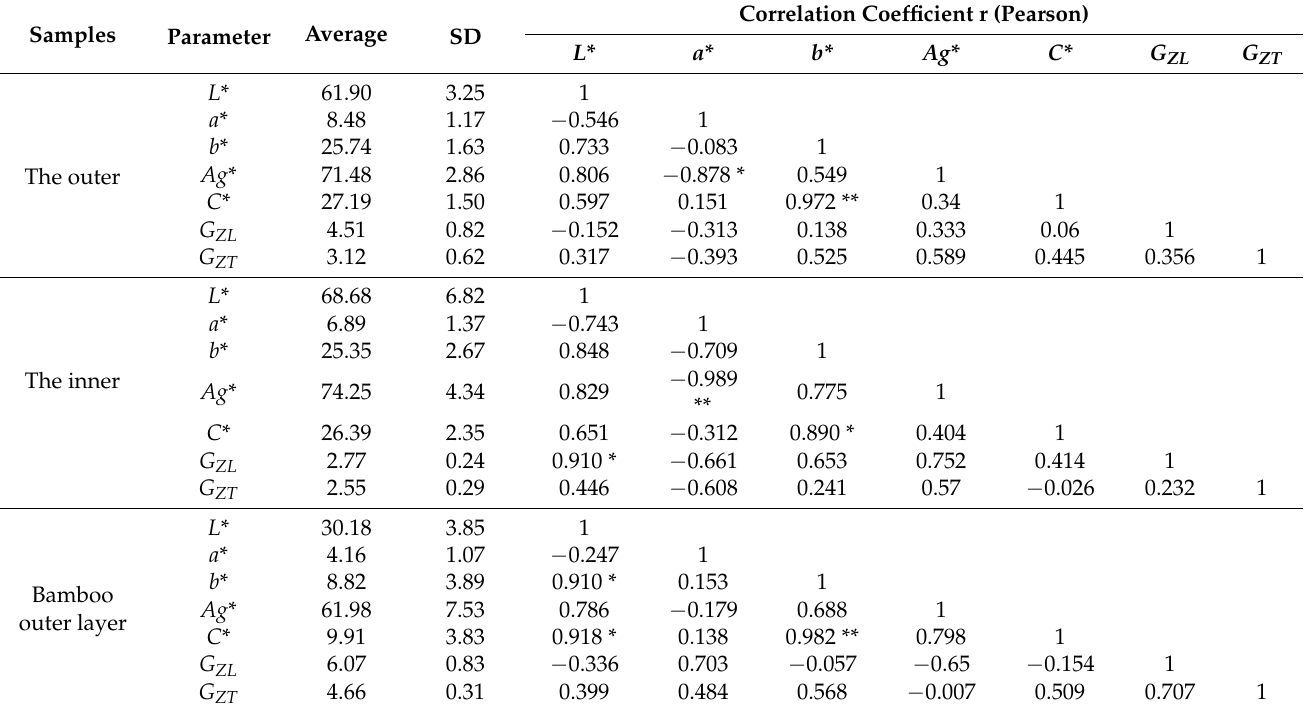
Table 5. Correlation analysis of seven visual physical quantities.